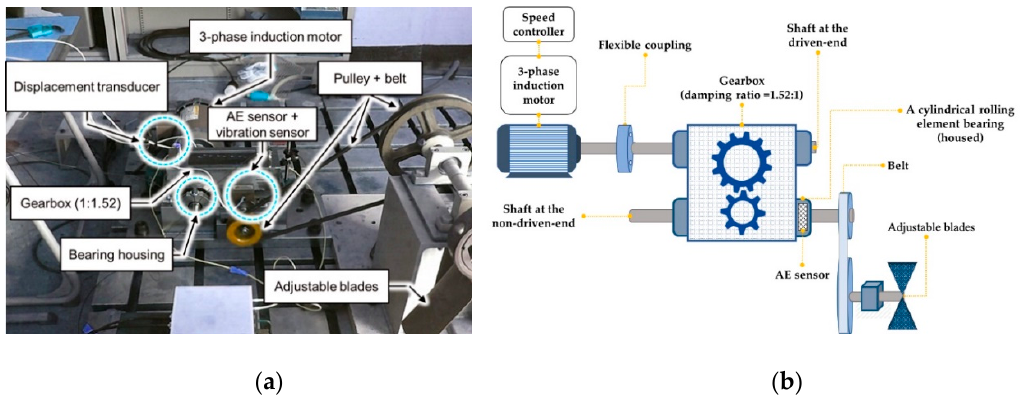
Figure 4. Testbed for collecting AE signals from compound faults: ( a ) real testbed component positions; ( b ) testbed diagram.